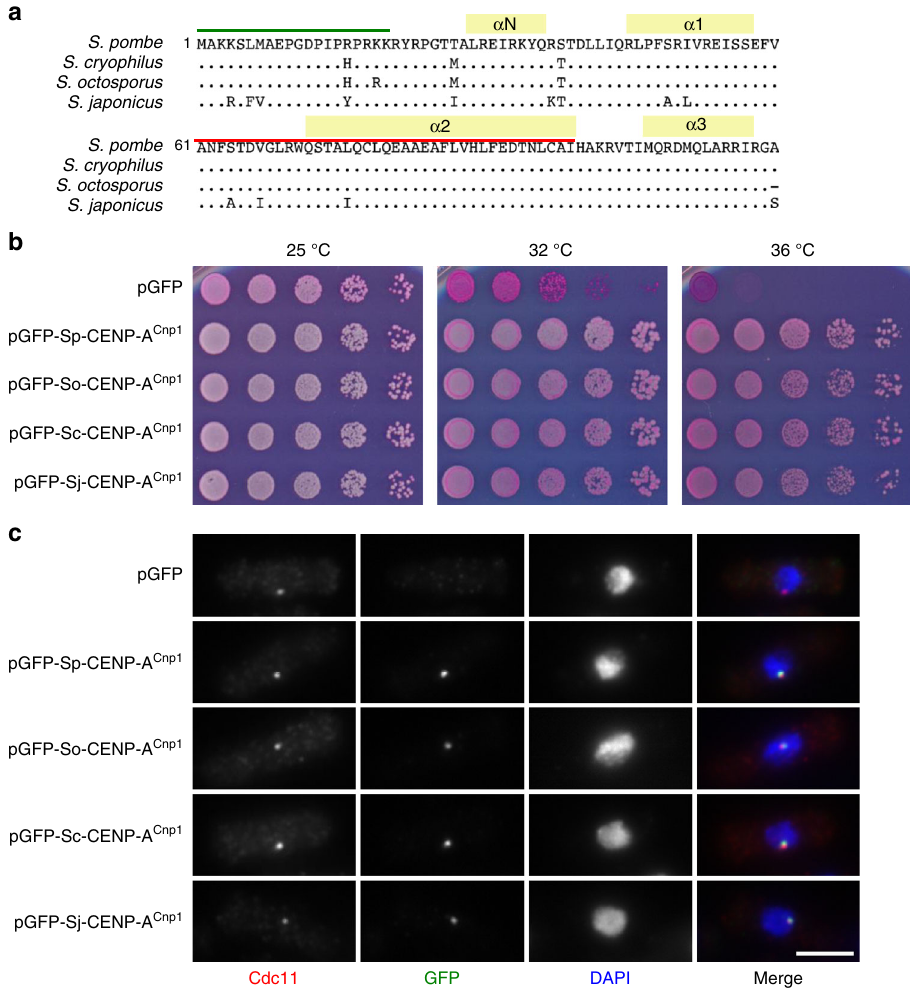
Fig. 5 Cross-species functionality of CENP-A Cnp1 proteins. a Alignment of Schizosaccharomyces CENP-A Cnp1 proteins. Positions of alpha helices (yellow), N-terminal tail (green) and CENP-A-targeting domain (CATD; red) are indicated. b S. pombe temperature-sensitive cnp1-1 cells expressing plasmid-borne GFP-CENP-A Cnp1 from the indicated species ( Sp , S. pombe ; So , S. octosporus ; Sc , S. cryophilus ; Sj , S. japonicus ), or GFP alone, were spotted on phloxine B-containing plates and incubated for 2 – 5 days at the indicated temperatures. c Localization of GFP-tagged CENP-A Cnp1 from indicated Schizosaccharomyces species in S. pombe . Wild-type S. pombe cells bearing plasmids described in a were grown at 32 °C before fi xation and staining with anti-GFP (green), anti- Cdc11 (red, spindle-pole body) and DAPI (blue, DNA). Centromeres cluster at the spindle-pole body in S. pombe . Scale bar, 5 μ m. Source data available as a Source Data fi Chromatin immunoprecipitation sequencing . A modi fi ed ChIP protocol was ChIP-quantitative PCR analysis . For analysis of CENP-A Cnp1 association with used. Brie fl y, pellets containing 7.5× 10 8 cells were lysed by four 1min pulses of minichromosomes bearing S. octosporus central-core DNA, three independent bead beating in 500 μ l of lysis buffer (50 mM HEPES-KOH, pH 7.5, 140 mM NaCl, transformants with established centromere function (indicated by ability to form 1 mM EDTA, 1% Triton X-100, 0.1% sodium deoxycholate), with resting on ice sectored colonies) for each minichromosome were grown in PMG-ade-ura cultures and fi xed with 1% formaldehyde for 15min at room temperature. ChIP was per- formed as previously described 57 . Brie fl y, 2.5× 10 8 cells were lysed by bead beating (Biospec) in 300 μ l Lysis Buffer (50 mM Hepes-KOH pH 7.5, 140 mM NaCl, 1 mM EDTA, 1% (v/v) Triton X-100, 0.1% (w/v) sodium deoxycholate). Lysates were sonicated (Bioruptor, Diagenode) for 20 min (30 s on/off, high setting), followed by centrifugation at 17,000 × g (2× 10 min) to pellet cell debris. Lysates were pre- cleared for 1h with 25 μ l of Protein-G agarose beads (Roche) and 10 μ l precleared lysate retained as ‘ input ’ sample. Three hundred microlitres of lysate was incubated overnight with 10 μ l sheep anti-CENP-A Cnp1 serum and 25 μ l Protein-G agarose beads. Beads were washed with Lysis Buffer, Lysis Buffer with 500 mM NaCl, WASH buffer (10 mM Tris-HCl pH 8, 0.25 M LiCl, 0.5% NP-40, 0.5% (w/v) sodium deoxycholate,1 mM EDTA) and TE. DNA was recovered from input and IP samples using Chelex resin (BioRad). Ten microlitres of anti-CENP-A Cnp1 sheep antiserum 57 (raised to the N-terminal 19 amino acids of S. pombe CENP- A Cnp1 ) and 25 μ l Protein-G-Agarose beads were used per ChIP. qPCR was per- formed using a LightCycler 480 and reagents (Roche), and analysed using Light- Cycler 480 Software 1.5 (Roche). Primers used in qPCR are listed in Supplementary Table 12. Mean %IP ChIP values for Sp-cnt or So-cnt on minichromsomes were normalized to %IP for endogenous S. pombe cnt1 . Error bars represent SD. Illumina primers for 12 – 15 cycles and library fragments of ~300 bp (insert plus